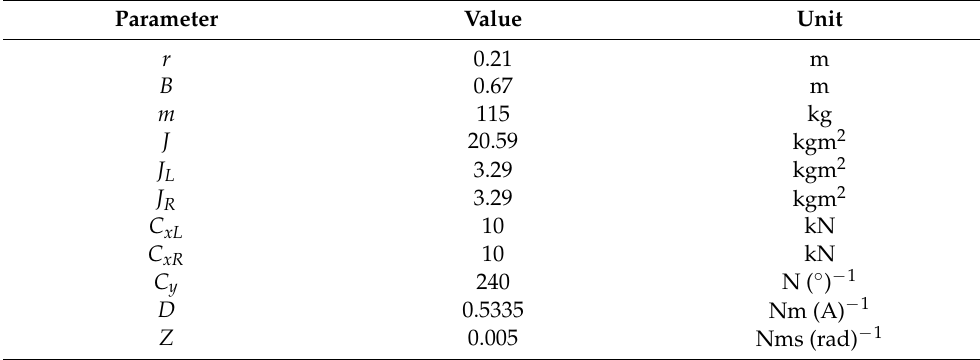
Table 1. Parameters of the robot